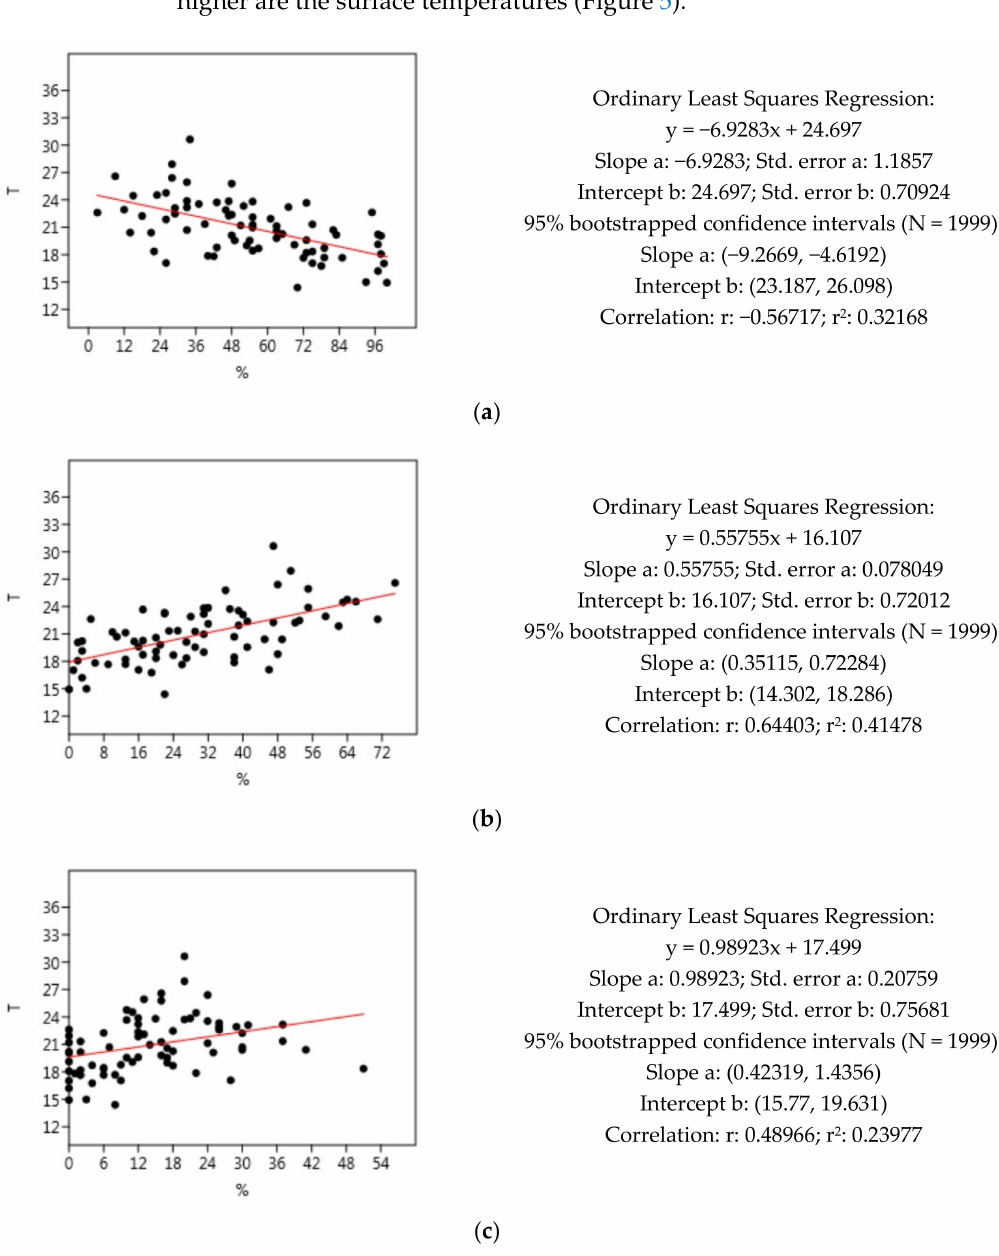
Figure 5. Linear regression dependence: ( a ) green areas; ( b ) impervious areas; ( c ) built-up